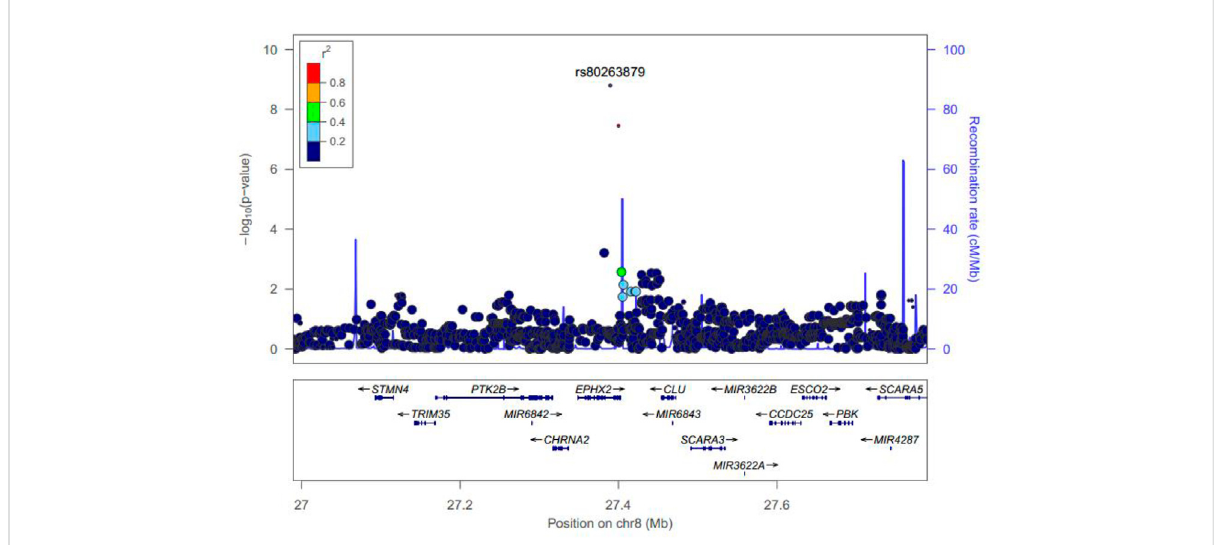
FIGURE 6 Regional plot of rs80263879 for SSWM. The most signi fi cant locus was marked violet. r 2 is the LD value of rs80263879 and any other locus.